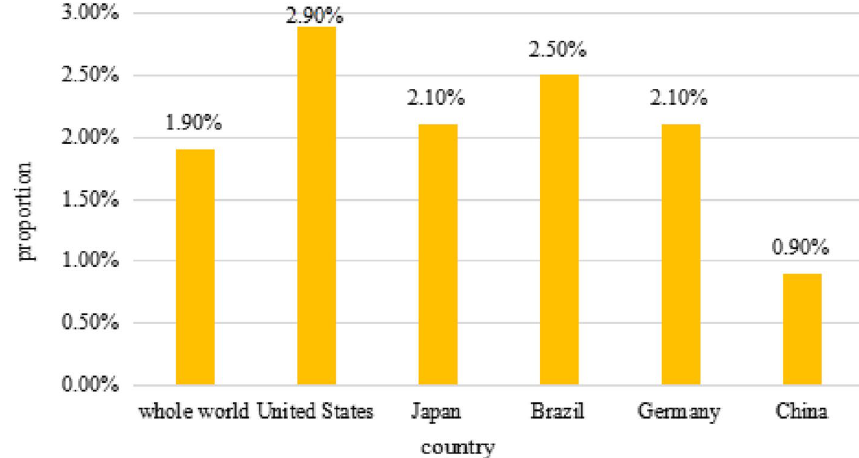
Fig. 10 Figure of the GDP proportion of the sports industry in various countries in